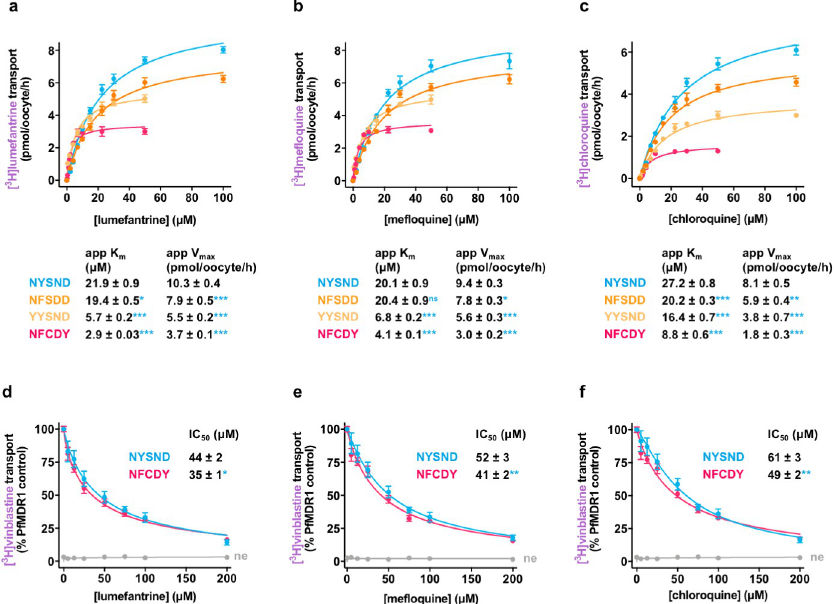
Fig 3. Characterization of lumefantrine, mefloquine, and chloroquine transport via PfMDR1. (a–c) There were significant differences in the apparent kinetic parameters of lumefantrine (a), mefloquine (b), and chloroquine (c) transport between field isoforms of PfMDR1. The concentration dependence of PfMDR1-mediated drug transport was calculated by subtracting the leakage from ne from that of oocytes expressing a PfMDR1 isoform at each drug concentration. (d–f) The transport of [ 3 H]vinblastine via PfMDR1 was inhibited by lumefantrine (d), [ 3 H]mefloquine (e), and [ 3 H]chloroquine (f). The data are the mean of n = 4 independent experiments (each yielding similar results), and the error is the SEM. The asterisks denote a significant difference from PfMDR1 NYSND ; � P < 0.05, �� P < 0.01, ��� P < 0.001, ns nonsignificant (1-way ANOVA). The data underlying this figure is supplied in S3 Data. ne, nonexpressing oocytes; PfMDR1, Plasmodium falciparum multidrug resistance protein 1.